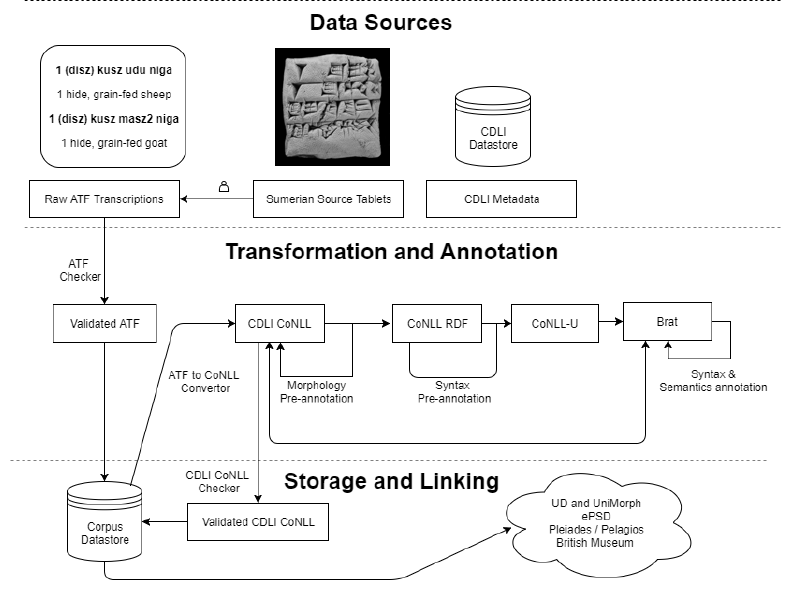
Figure 4. Corpus annotation pipeline: From ATF to RDF. Illustrated for https://cdli.ucla.edu/P322539, an Ur III cuneiform text from Garshana, Mesopotamia [22], no. 851; picture reproduced here with the kind permission of David I.